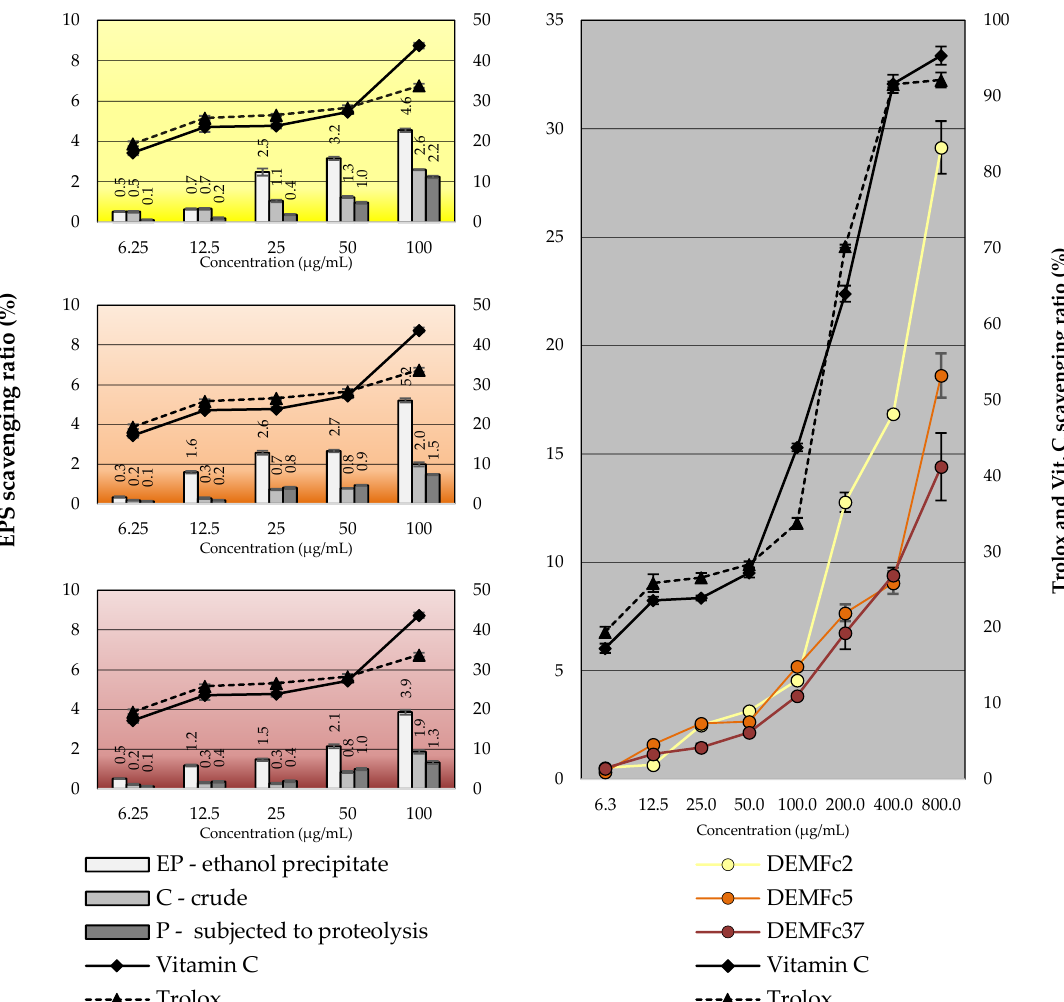
Figure 15 . Scavenging ability (determined with the ABTS method) of the EPS obtained from cultures of three F. culmorum strains. ( A ). Comparison of ethanol precipitate EPS (EP), crude EPS (C), and proteolysed EPS (P) used in a concentration range of 6.25-100 µg/mL; ( B ). Ethanol precipitate EPS (EP) used in a concentration range of 6.25 – 100 µg/mL and in a range of 100 – 800 µg/mL. Standard deviations are shown as deviation bars ( n = 9).